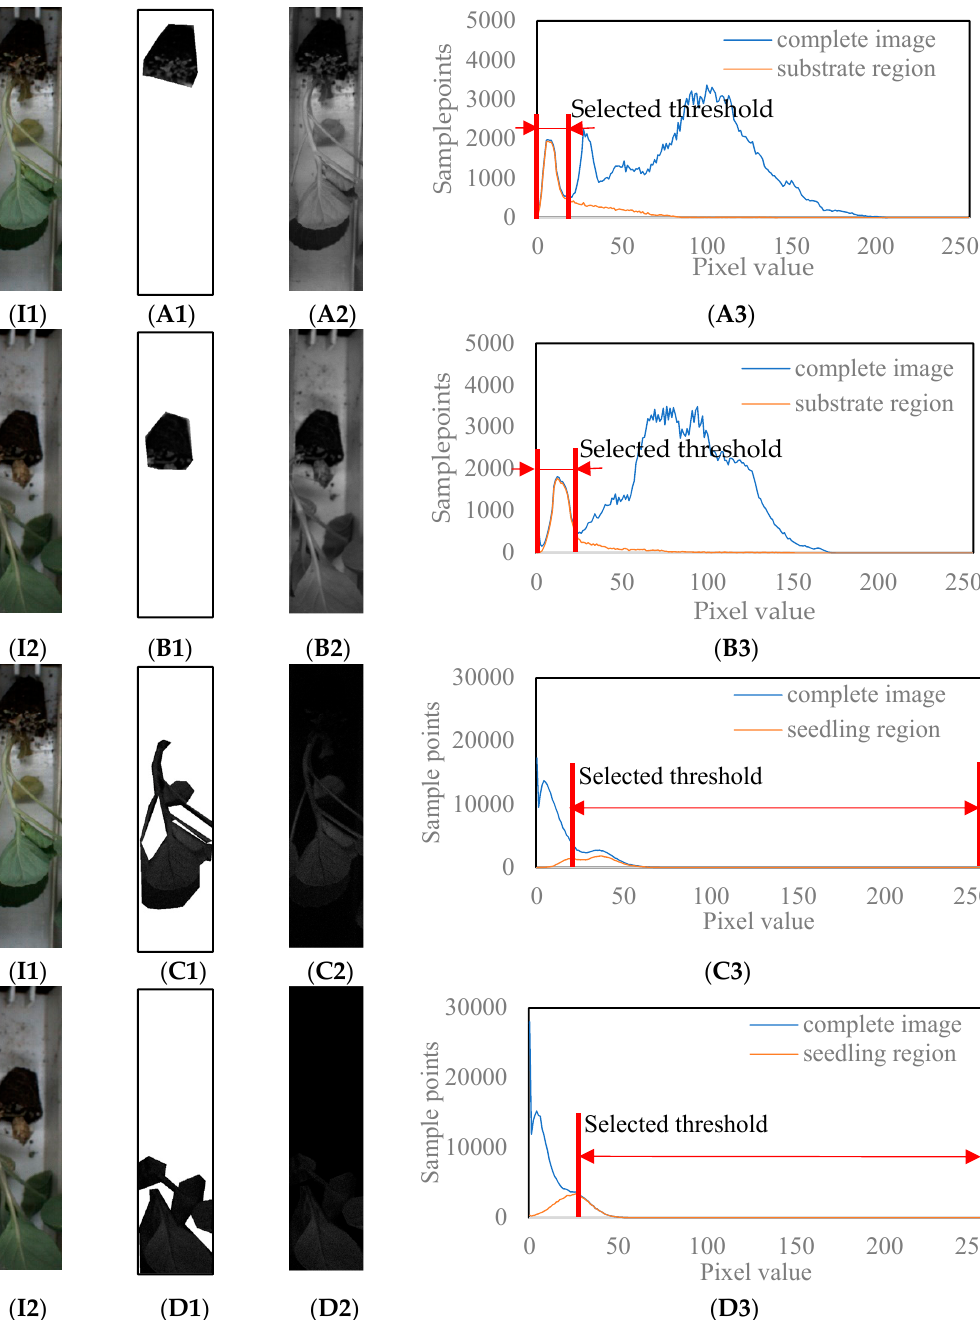
Figure 8. Grayscale histogram analysis of the substrate and seedling region. ( I1 , I2 ) The original image; ( A1 , B1 ) the cropped substrate region in the G channel; ( A2 , B2 ) the complete image in the G channel; ( A3 , B3 ) the grayscale histogram of the cropped substrate region and the complete image in the G channel; ( C1 , D1 ) the cropped seedling region in the excess green color space; ( C2 , D2 ) the complete image in the excess green color space; ( C3 , D3 ) the grayscale histogram of the cropped seedling region and the complete image in the excess green color space.